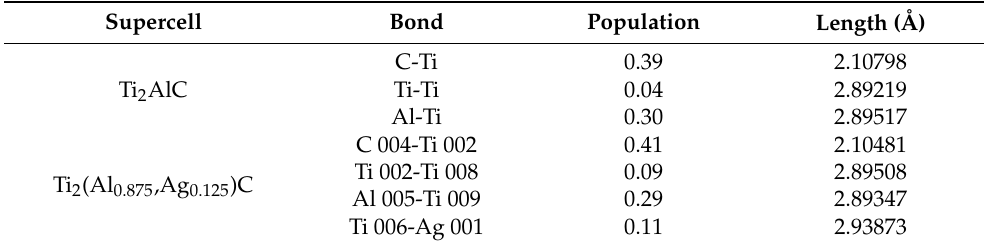
Table 3. Mulliken bond overlap populations of Ti 2 AlC and Ti 2 (Al 0.875 ,Ag 0.125 )C supercells.